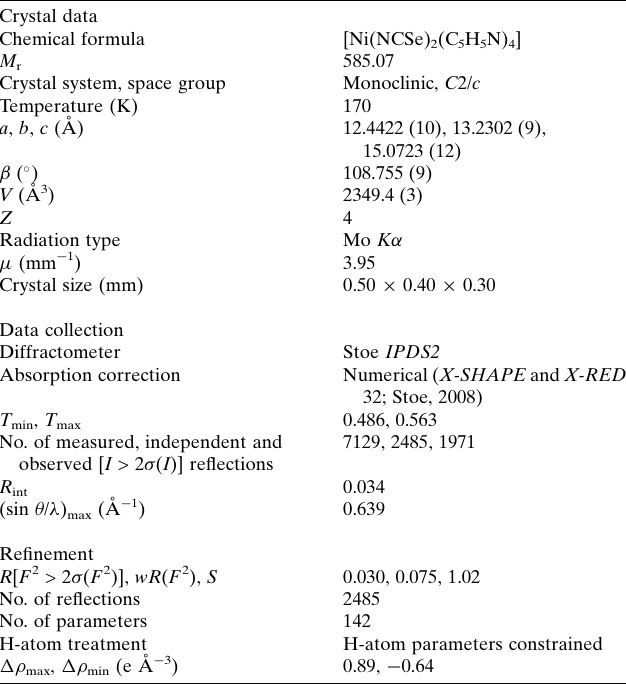
Table 3 Experimental details. Crystal data Chemical